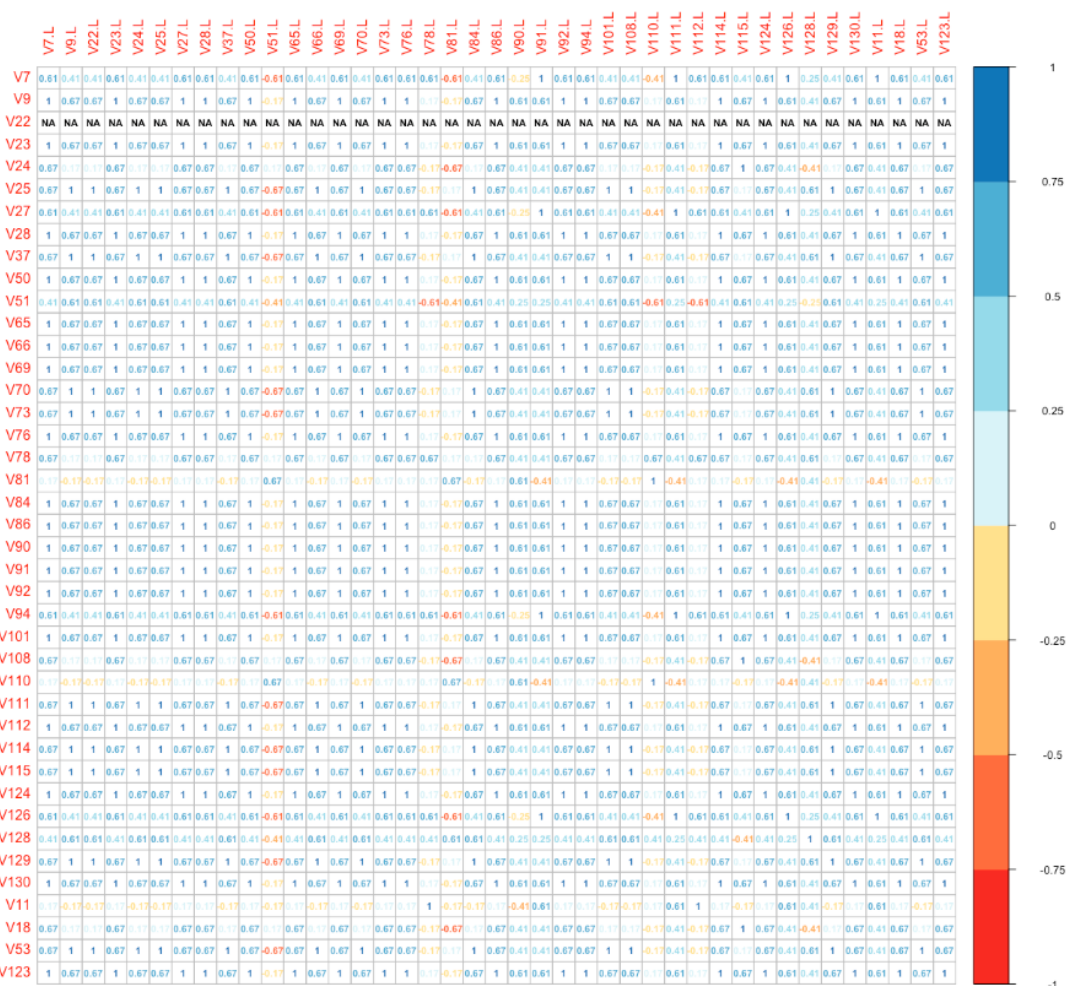
Figure 3. Distance plot (vulvar site vs. lymph nodal site).